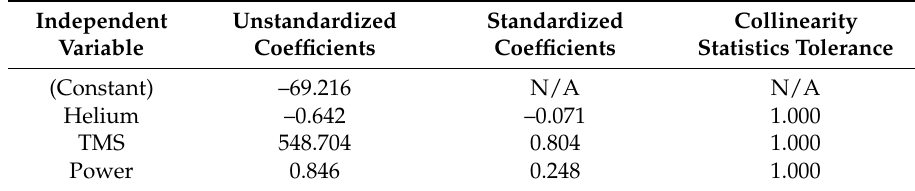
Table 8. Coefficients of the regression